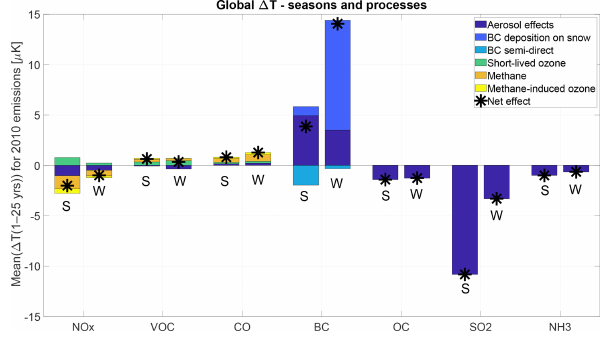
Figure 6. The global temperature response (µK) of Finnish emis- sions in 2010 by applying the mean temperature 1–25 years after the pulse emission. This figure compares emissions occurring in summer (S) vs. winter (W) by applying ARTP values (Aamaas et al., 2017; Sand et al., 2016). The responses are divided into six dif- ferent